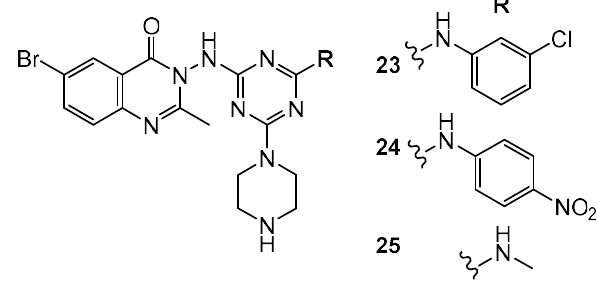
Figure 6. Structure of VEGF inhibitors.